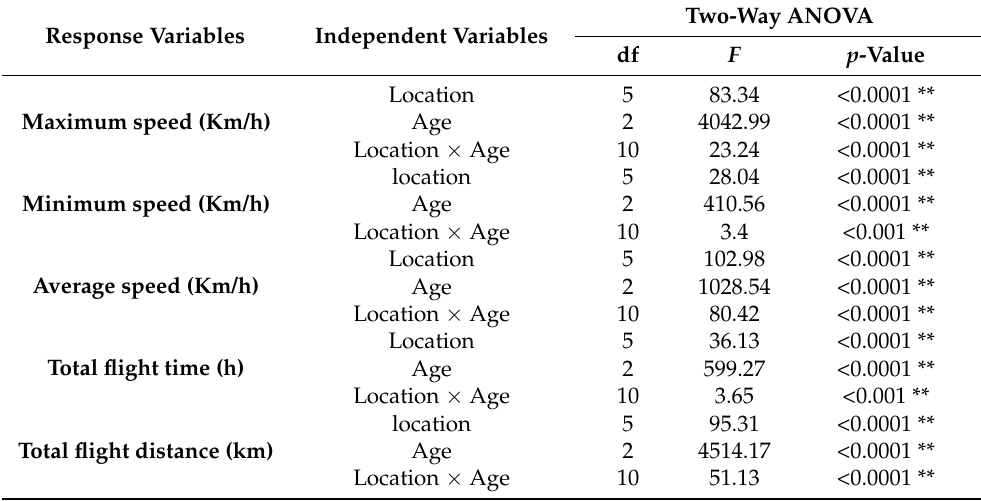
Table 2. The impact of age on the flight ability of tested female Lymantria dispar asiatica assessed by a two-way ANOVA for maximum/minimum/average speed, total flight time and fight distance.